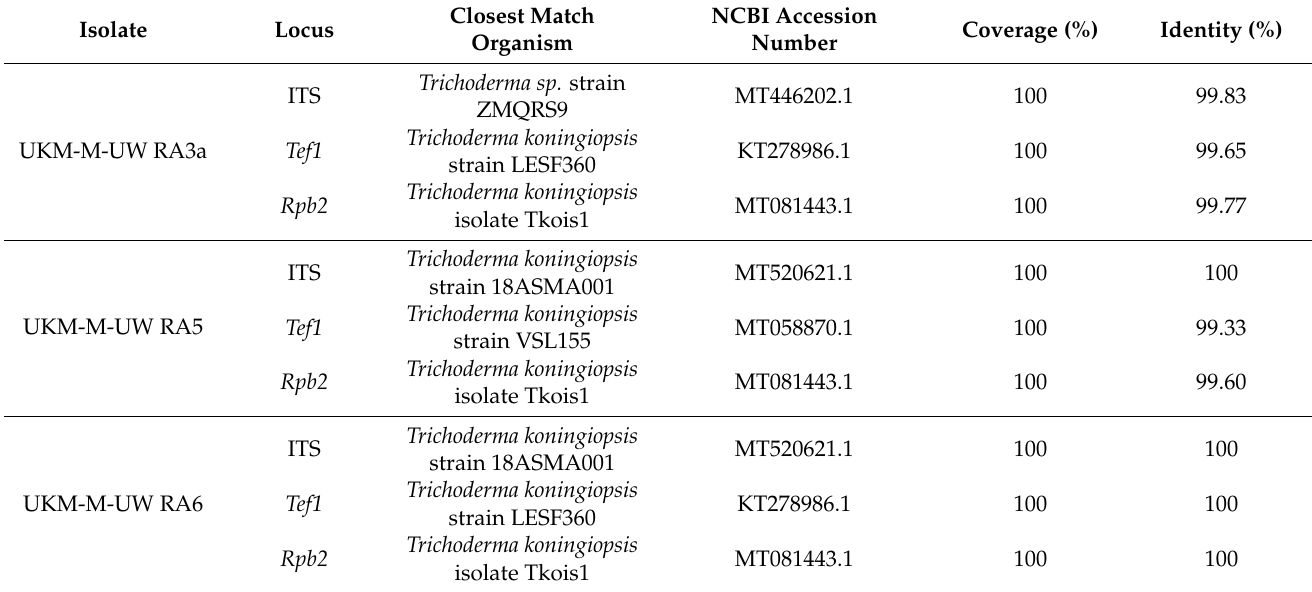
Table 3. Molecular identification of the three fungal isolates RA3a, RA5 and RA6 based on Sanger sequencing of the three DNA barcodes ITS, Tef1 and Rpb2